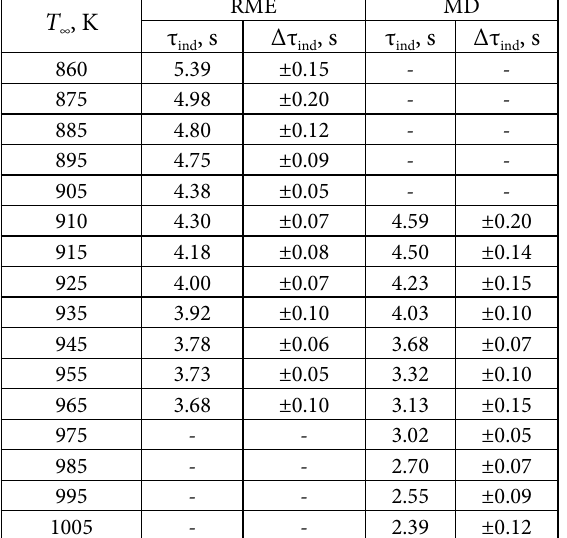
Table 1. Experimental data on MD and RME s ingle droplet ignition delay time reliance upon ambient temperature. Initial droplet radius r = 1,125 mm 0